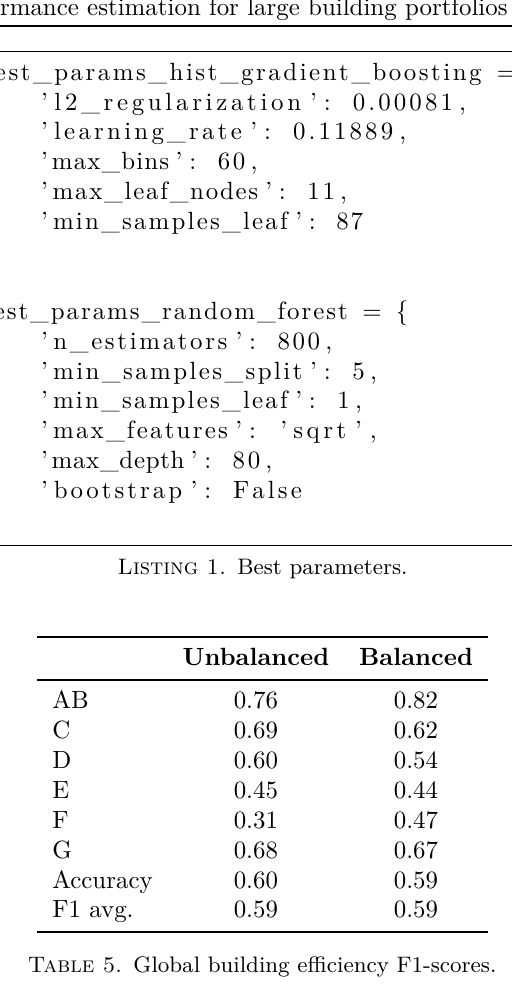
Table 4. Comparison of the best classifiers with their F1-score average across class.